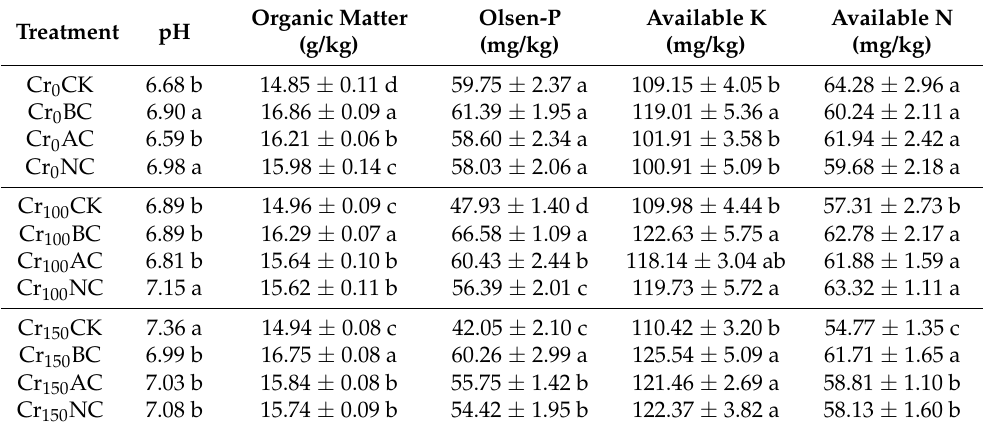
Table 1. Effects of BC, AC, and NC application on the physicochemical properties of soil under Cr